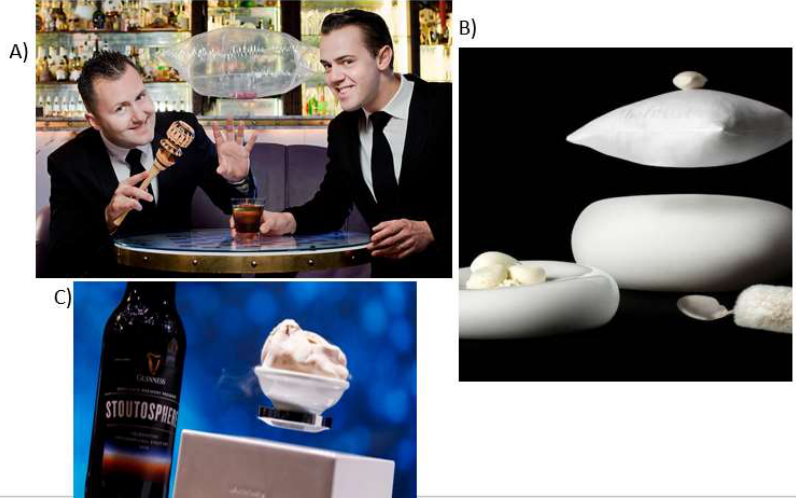
Figure 3. Three examples of levitating drinks / dishes. ( A ) Bar Artesian in London; ( B ) The Fat Duck floating pillow Counting Sheep dessert, in which a meringue rests on a pillow that floats and spins six inches above the table [63]; ( C ) Kitchen Theory levitating ice cream [Photo credit: John Carey]. Notice how in all three cases while the service element of the drink / dish is in some sense magical, the tasting experience itself is